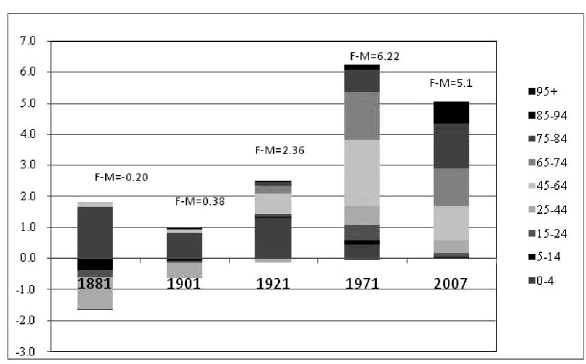
Figure 6 – Contributions (in fraction of years) of the different age groups to the male-female differ- ence in life expectancy at